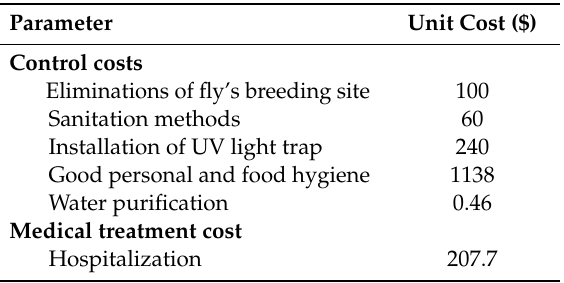
Table 6. Cost values for control simulations.